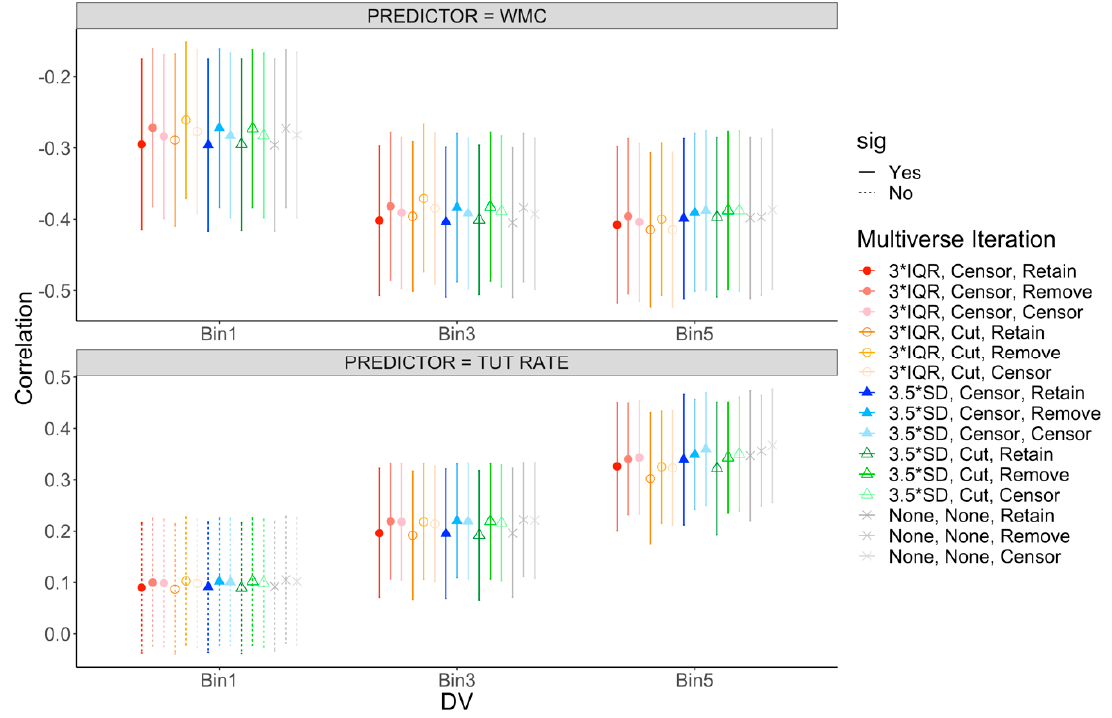
Figure 3. Mini-multiverse decision tree. Solid black boxes represent decisions that were made in every task in every multiverse iteration. Dashed black boxes include decisions that were made in some tasks (e.g., those with thought probes or conflict trials) in every multiverse iteration. Retain = kept outlier in dataset. Remove = remove outlier (trial or subject) from dataset. Censor = change outlying value to specified cutoff.